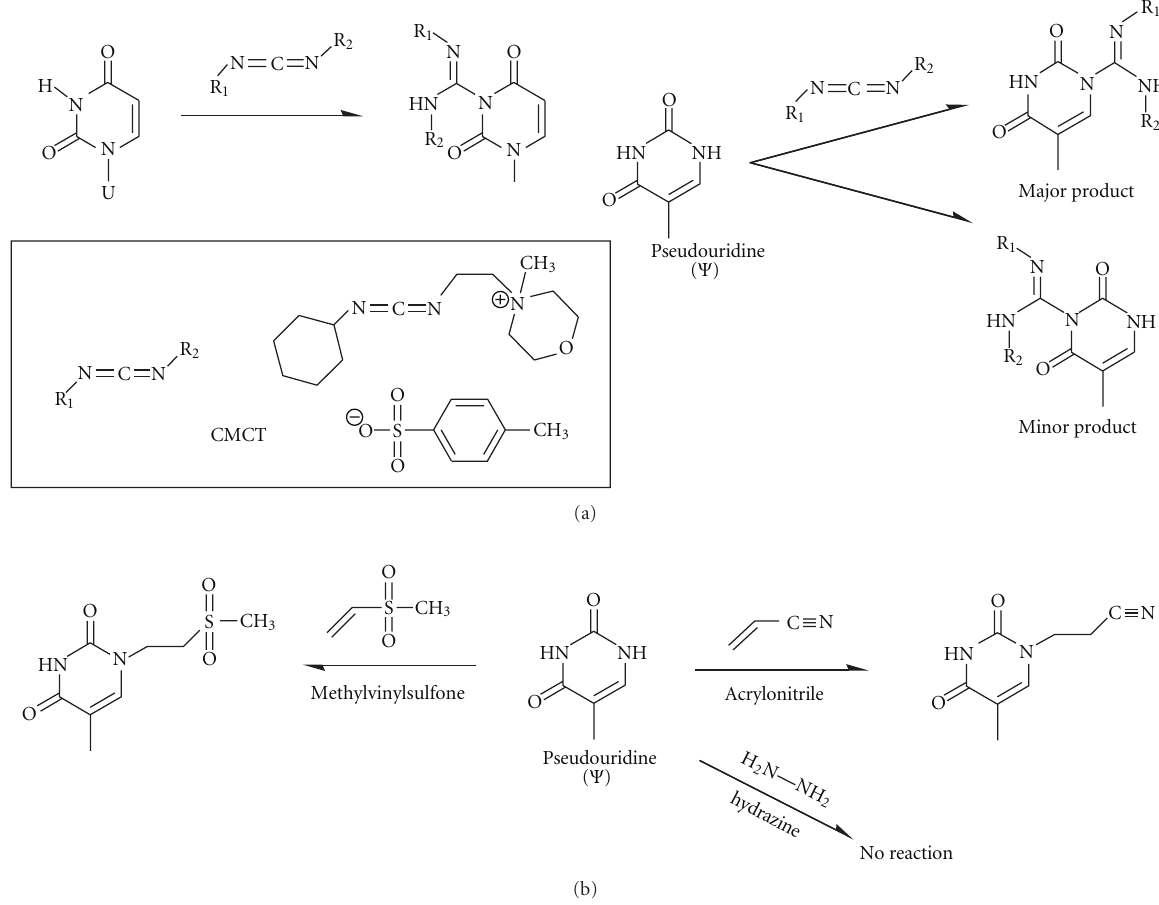
Figure 5: Pseudouridine ( Ψ -) specific reagents. (a) Pseudouridine and uridine reactivity with CMCT and similar water-soluble carbodiimides. Structural formula of CMCT is shown on the left. (b) Pseudouridine reactions with methylvinylsulfone and acrylonitrile. Pseudouridine residues are resistant to hydrazine, while unmodified uridines are specifically cleaved (see Figure 2(a)).